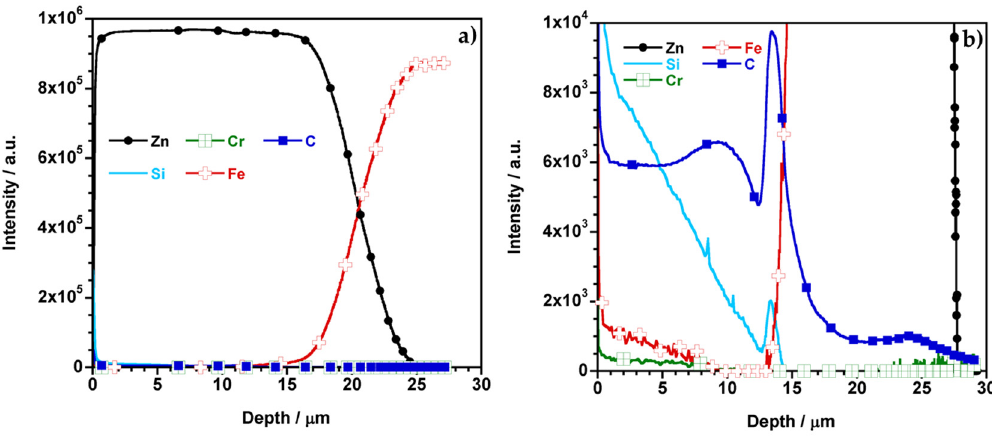
Figure 8. GD ‐ OES depth profiles for Zn, Si, Cr, Fe and C for ( a ) HDGS coated with 1 layer of OIH synthesized by sol ‐ gel method. Detailed view is shown in ( b ).